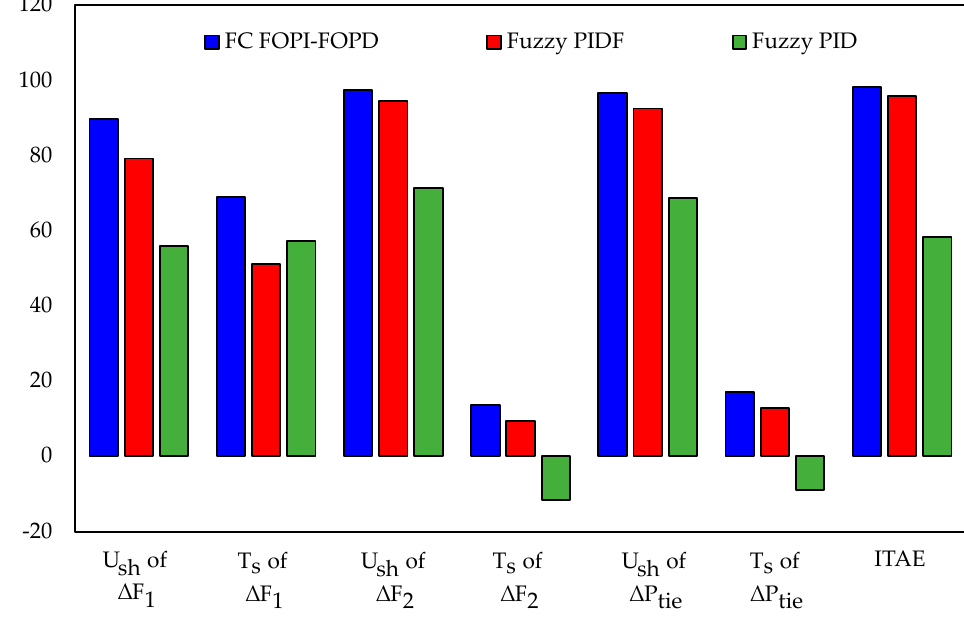
Figure 7. Percentage of betterment with different